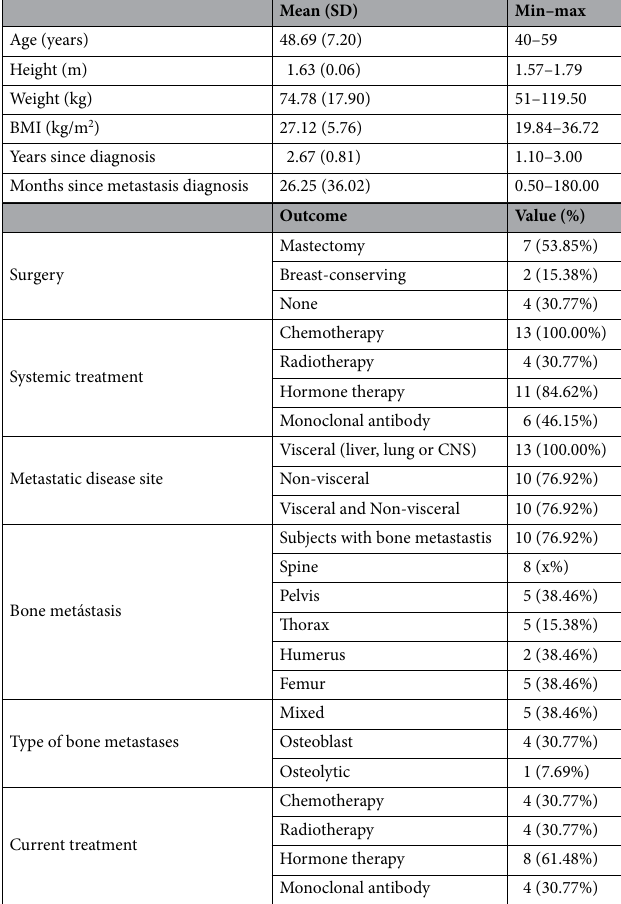
Table 1. Participant descriptive, medical and oncological variables (n = 13). BMI: body mass index; CNS: central nervous